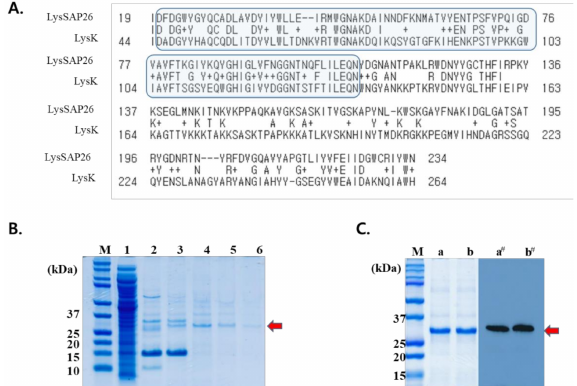
Figure 1. In silico analysis and purification of LysSAP26. ( A ) Two amino acid sequence alignments between LysSAP26 and LysK using NCBI protein BLAST. Highlighted area: cysteine, the histidine-dependent amidohydrolase / peptidase (CHAP) domain. Middle line reports that letters are an identical match, + is a positive match, space is a match with zero, and dashes are gaps. ( B ) Protein analysis by sodium dodecyl sulfate–polyacrylamide gel electrophoresis and ( C ) Western blot analysis of LysSAP26. The red arrow indicates the 30.1 kDa LysSAP26 endolysin with a 6-histidine tag.